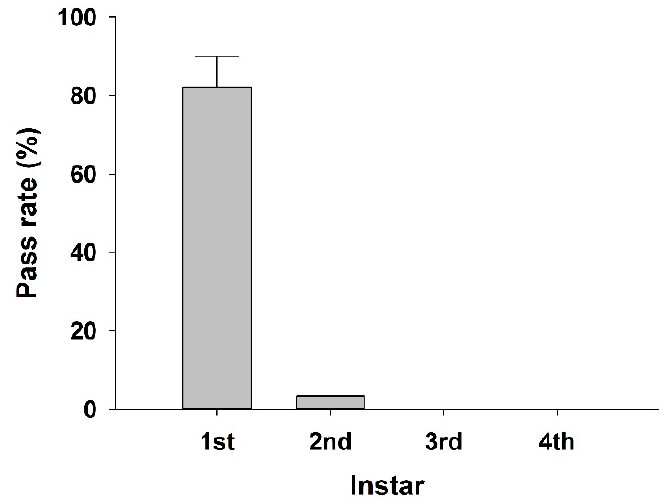
Figure 2. Pass rate of the four instars of Glyptotendipes tokunagai larvae through a granular activated carbon (GAC) column.